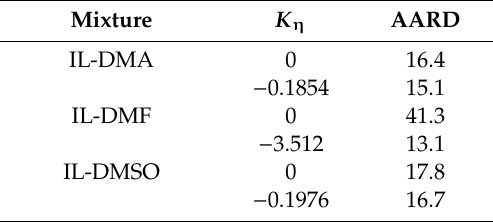
Table 15. The parameter K η for the hard-sphere theory in Equation (17). Mixture K